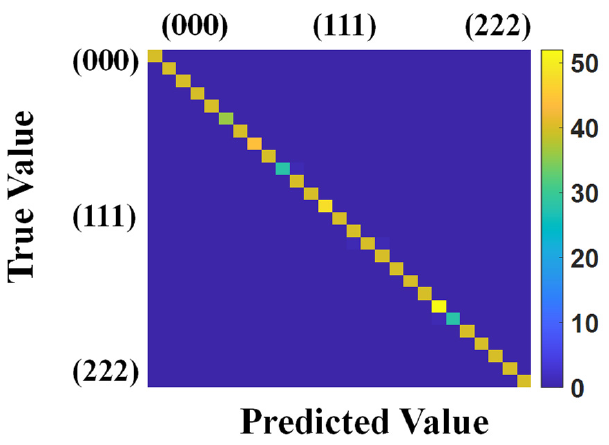
Figure 10. The confusion matrix when multiple monitored positions are perturbed simultane- ously.